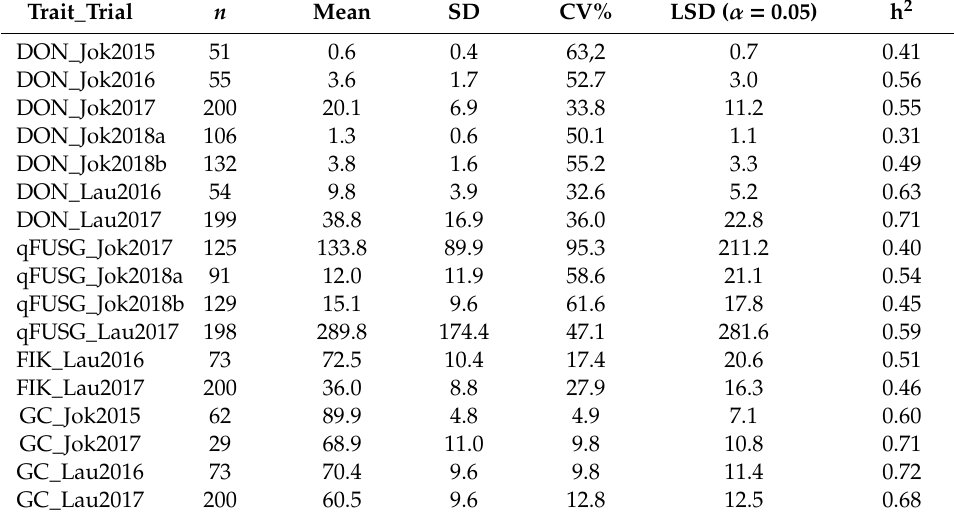
Table 2. Descriptive statistics for DON content, qFUSG, Fusarium -infected kernel (FIK) and germination capacity (GC) traits for each trial. Trait_trial describes the trait and location * year of testing, n equals the number of unique lines in the TRIAL, mean is the arithmetic mean, standard deviation (SD) the standard deviation, CV% is the coe ffi cient of variation after the spatial correction, similarly least significant di ff erence (LSD) values corresponds to the values after the spatial correction, with critical level of α = 0.05 and h 2 is the broad-sense heritability based on Piepho and Möhring (2007) [110].